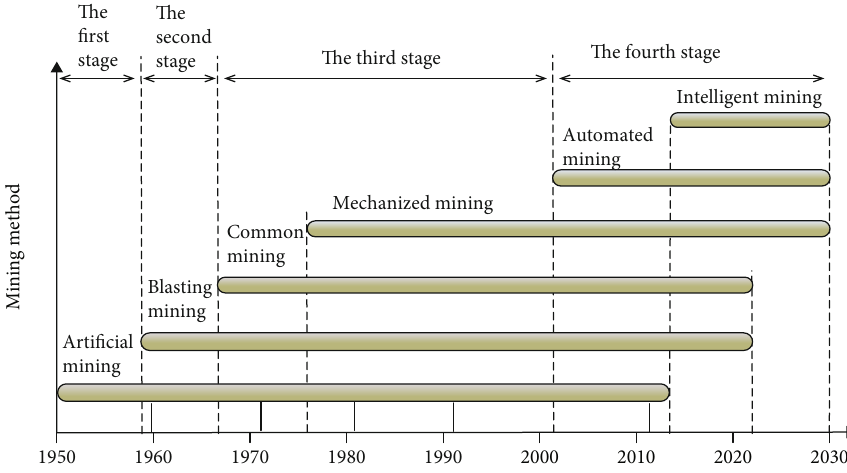
Figure 3: The development history of intelligent coal mine construction in